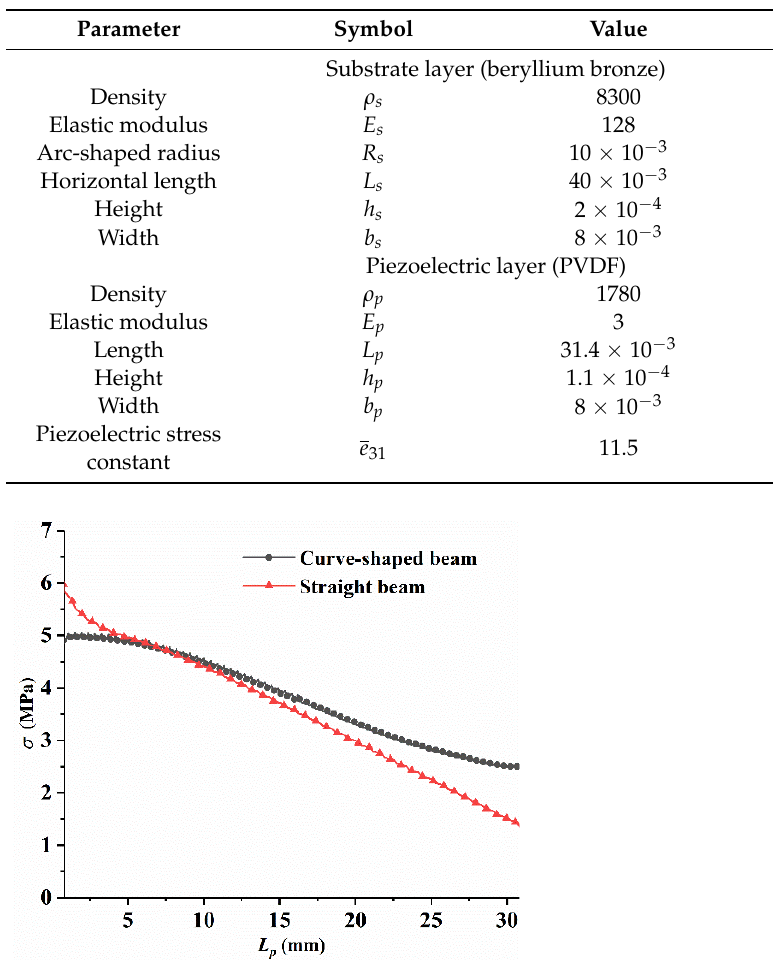
Figure 2. Comparison of stress distribution of PVDF on the curve-shaped beam and the straight beam.